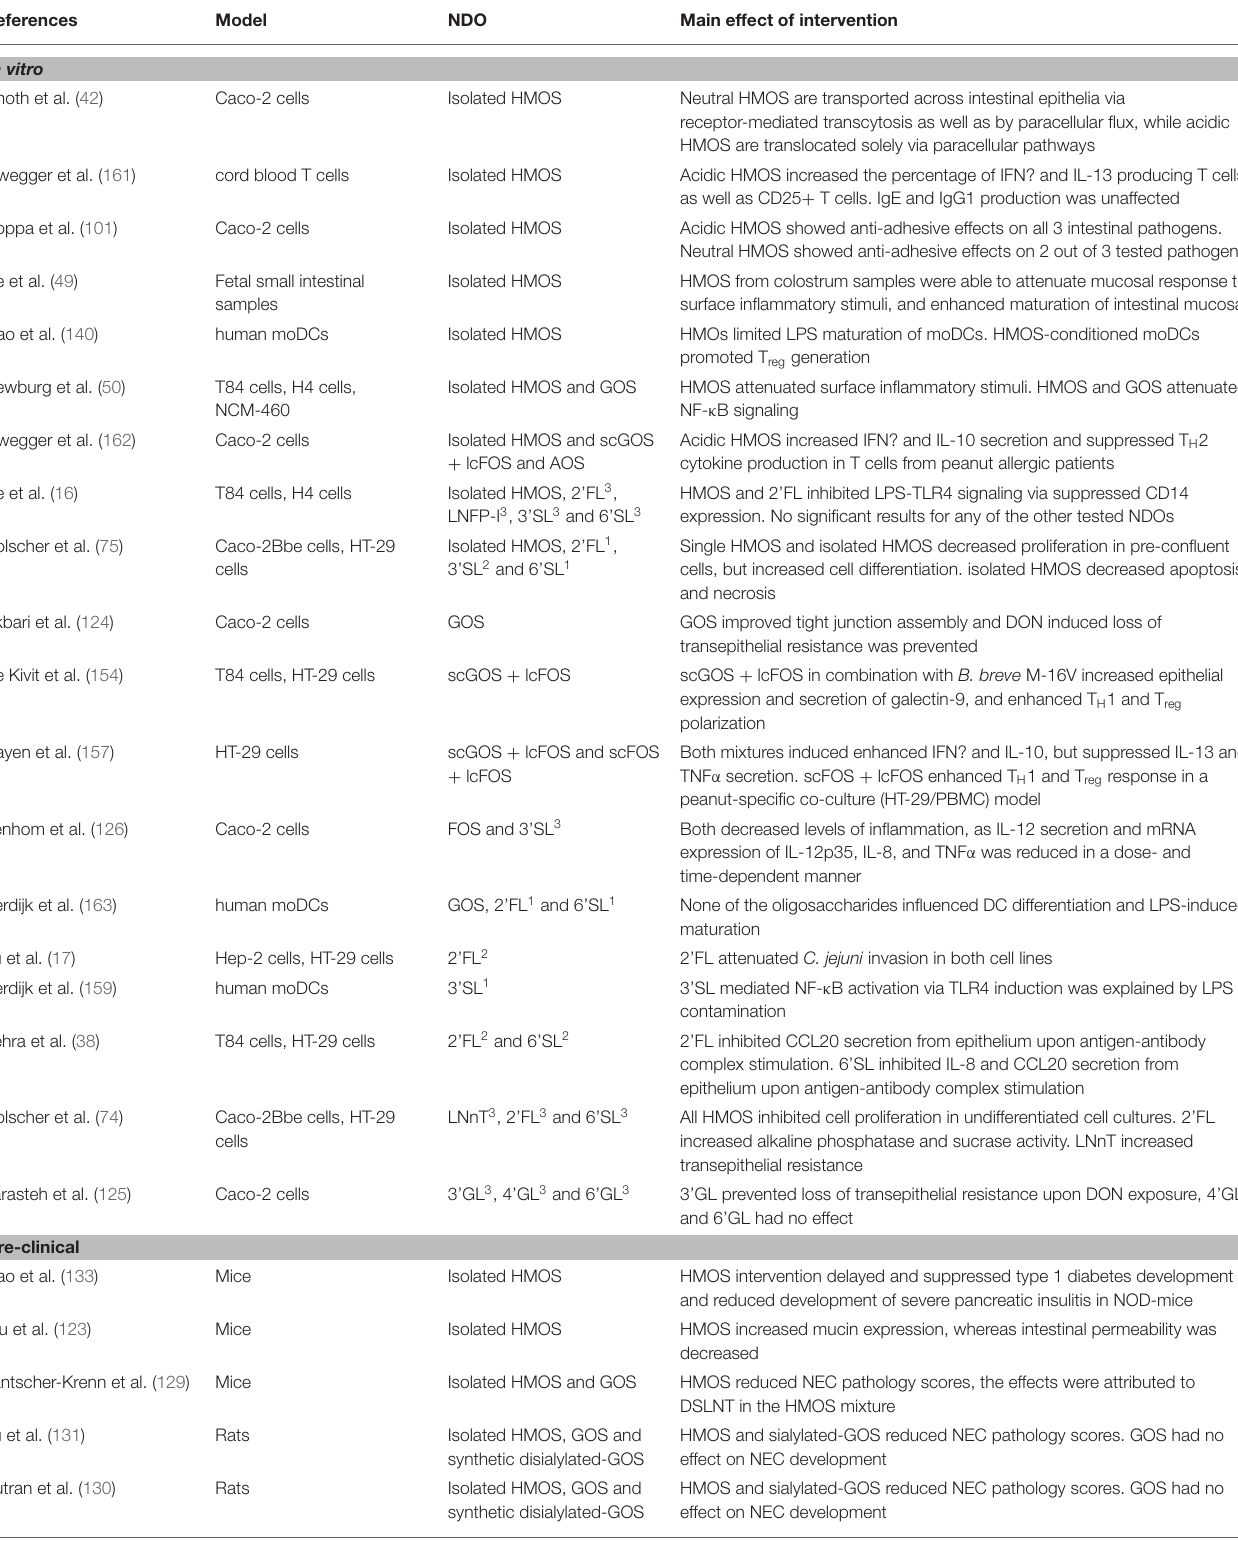
TABLE 2 | Overview of studies included in this review, which describe effects of non-digestible oligosaccharides (NDO) on immune